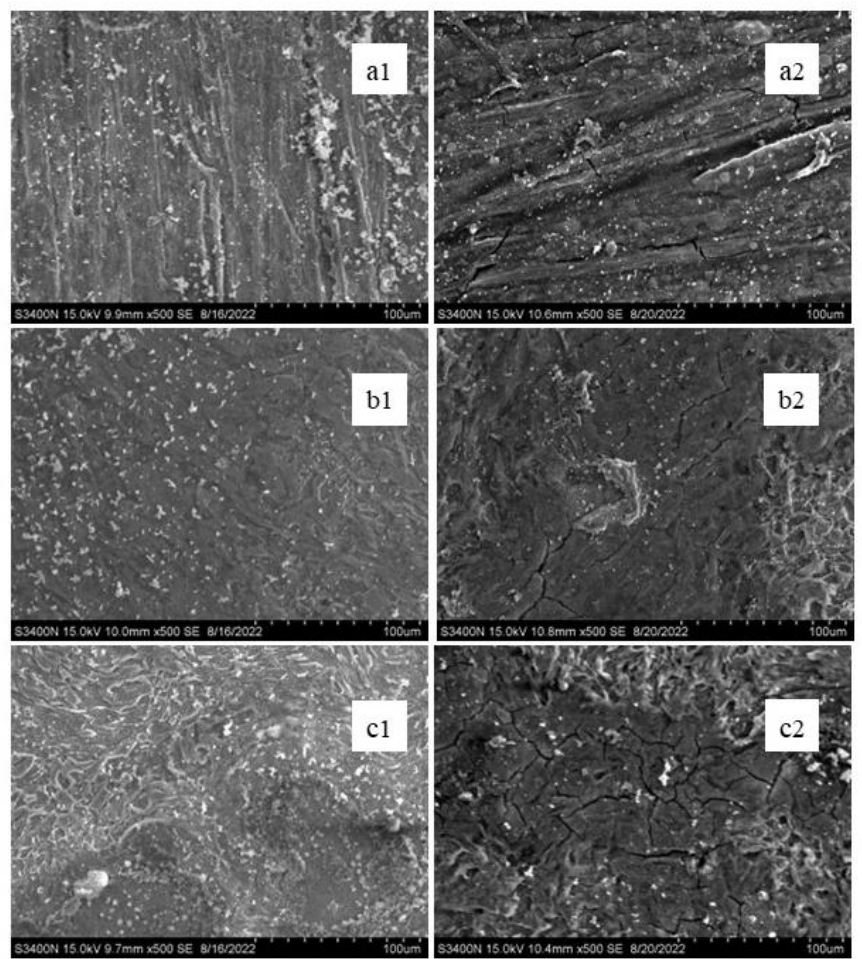
Figure 11. SEM macro-morphology characteristics of Q345B steel in 3.5 wt.% NaCl solution for 3 days: ( a1 ) un-USPed; ( b1 ) 200 s-2080 W-11 mm; ( c1 ) 600 s-2080 W-11 mm; for 7 days: ( a2 ) un-USPed; ( b2 ) 200 s-2080 W-11 mm; ( c2 ) 600 s-2080 W-11 mm.